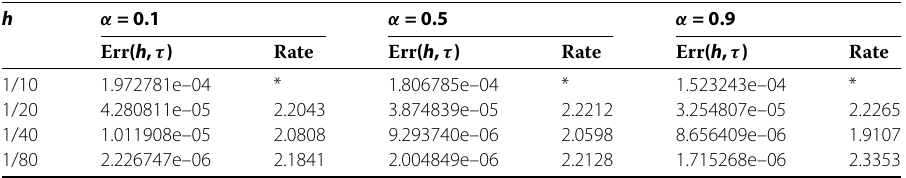
Table 6 Numerical errors and convergent orders with β = 1.5, λ = 2, T = 1, when q = 4, τ = h 1/2